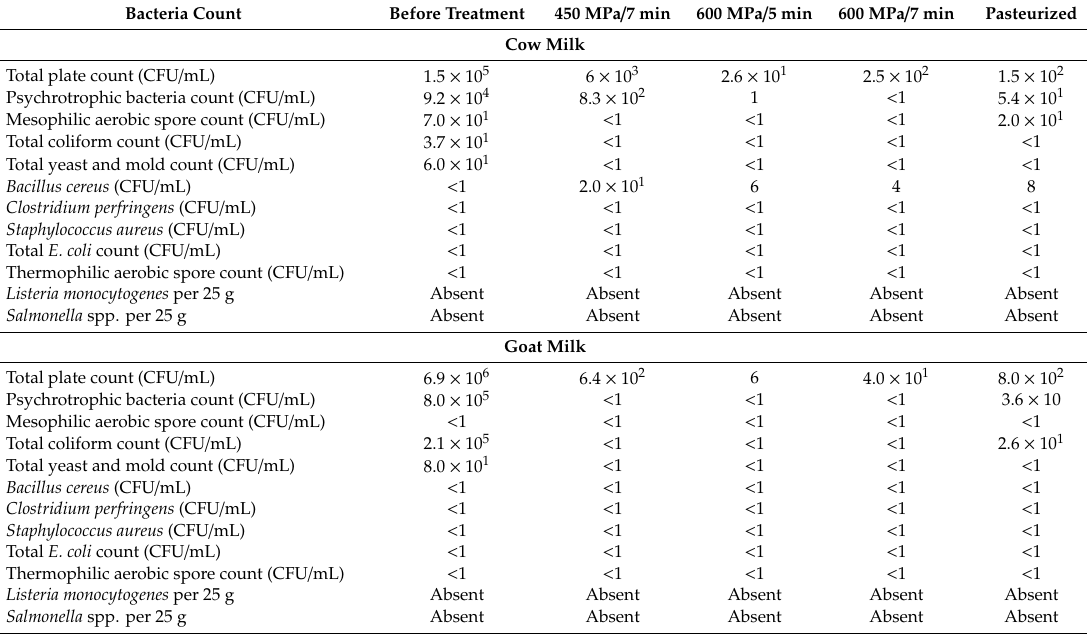
Table 2. Microbiological properties of cow and goat milk before and after treatment. Bacteria